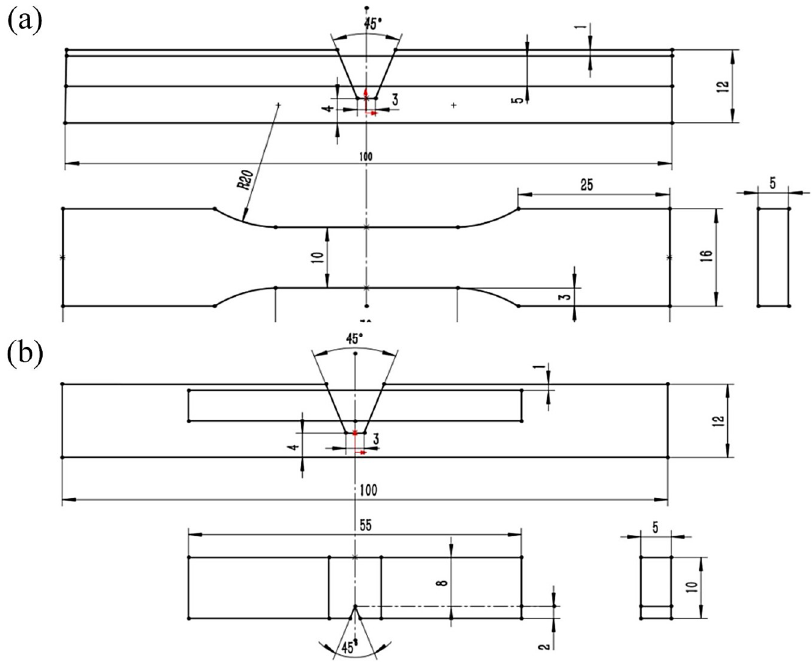
Figure 4. Schematic diagrams of dimensions and extracted locations of ( a ) tensile test samples and ( b ) impact test samples (all dimensions are in